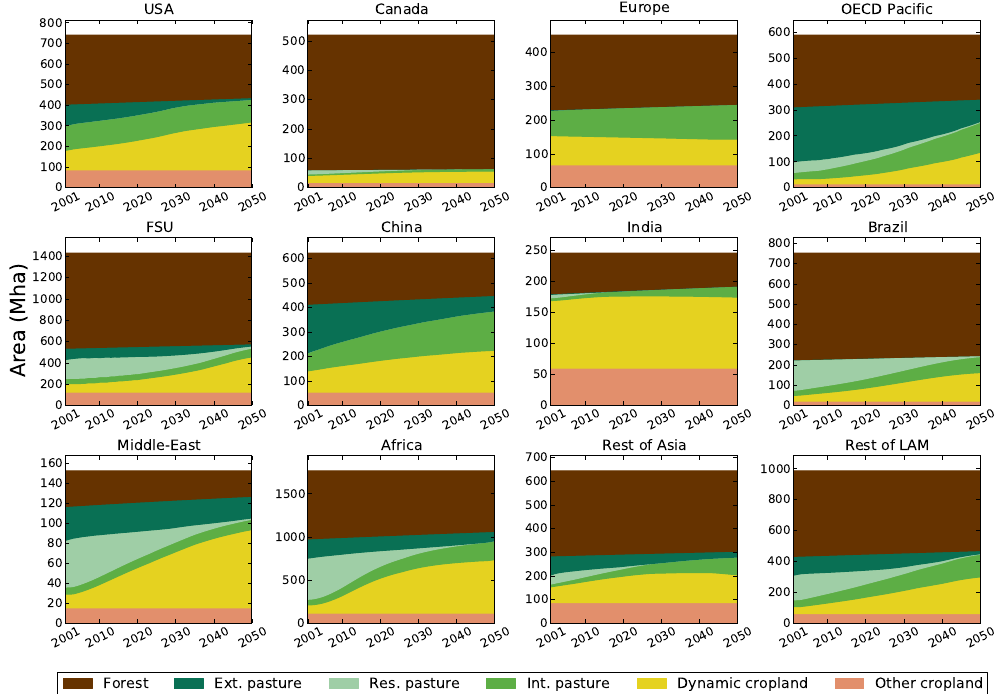
Fig. 16. Land-use changes simulated by the Nexus Land-Use. Expansion of agricultural areas is set to 10% and fertiliser and pesticide price increases by +100% up to